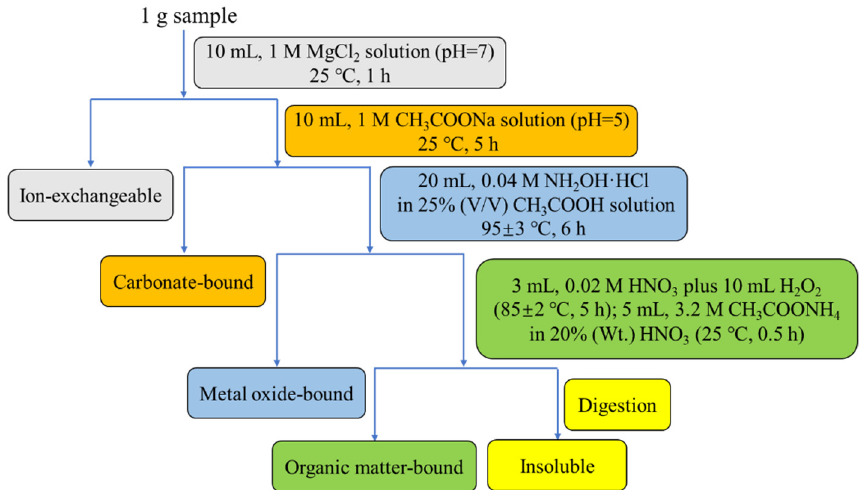
Figure 1. Diagram of the sequential chemical extraction procedure.